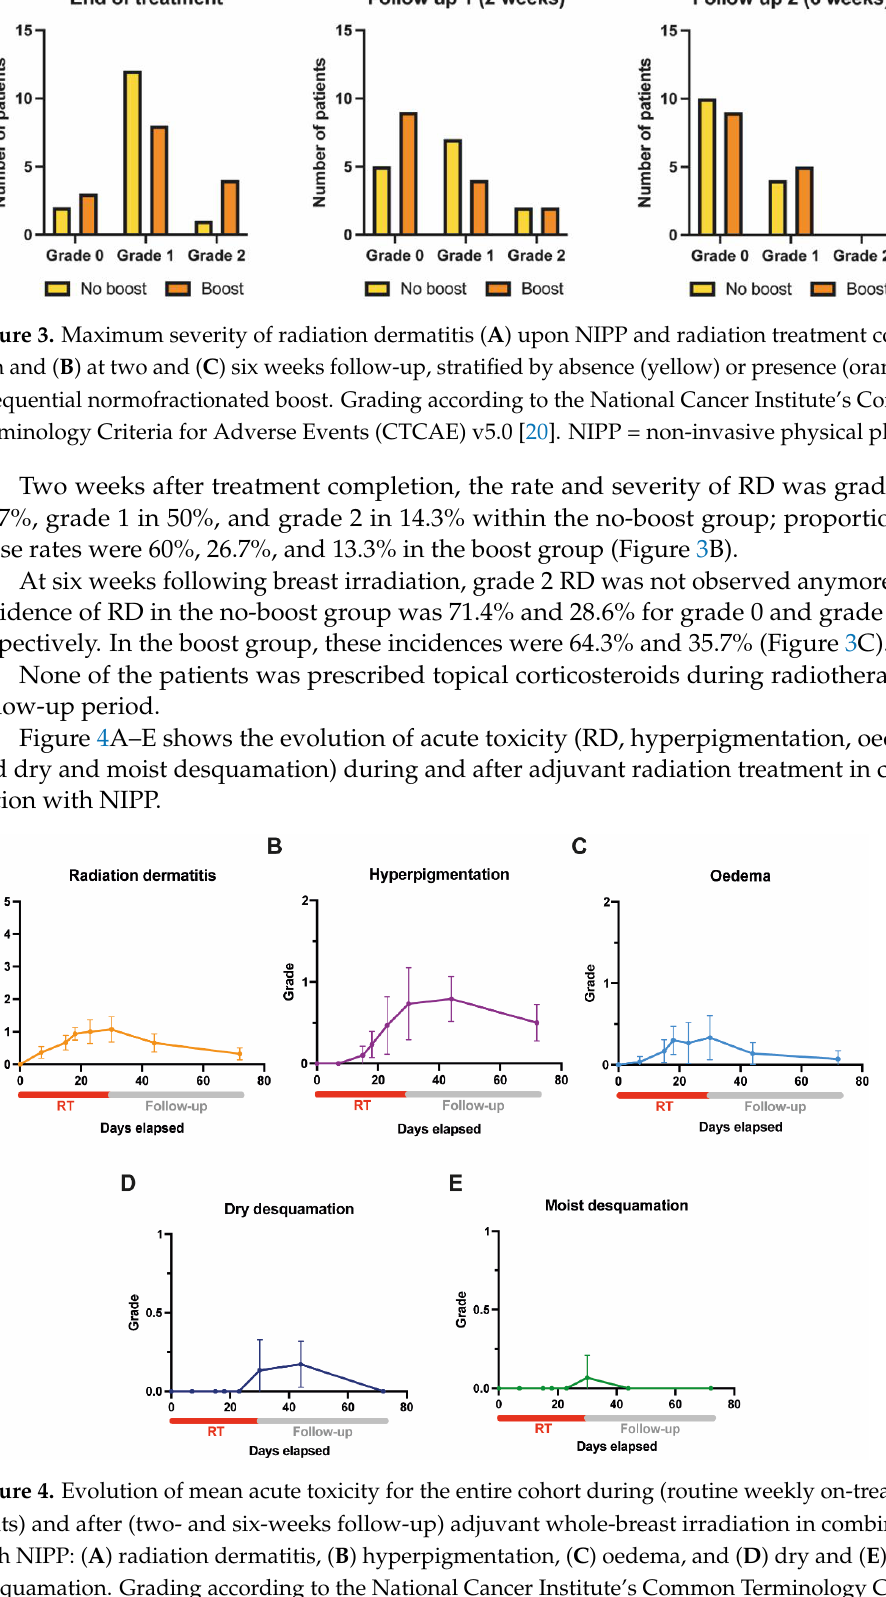
Table 3. Results of the patient-assessed modified Radiation-Induced Skin Reaction Assessment Scale (RISRAS) questionnaire upon treatment completion [21]. All items were scored on a 4-point Likert scale. n (%)